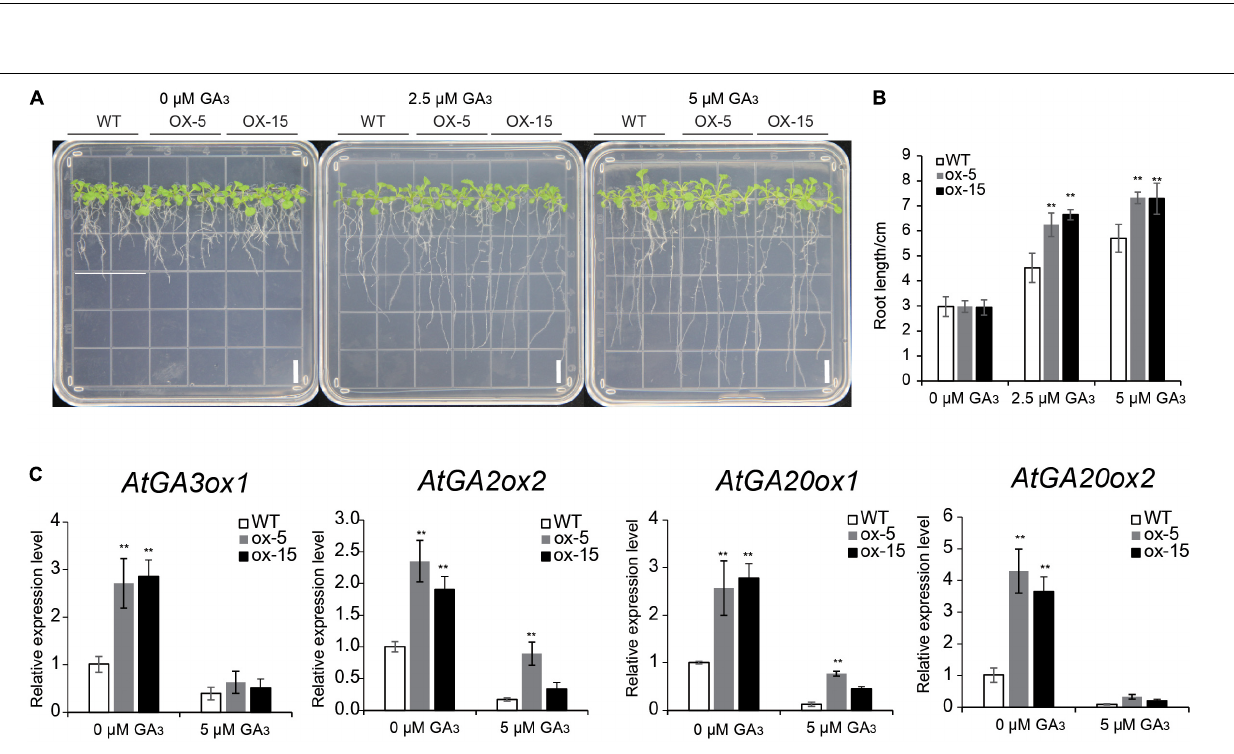
Frontiers in Plant Science |